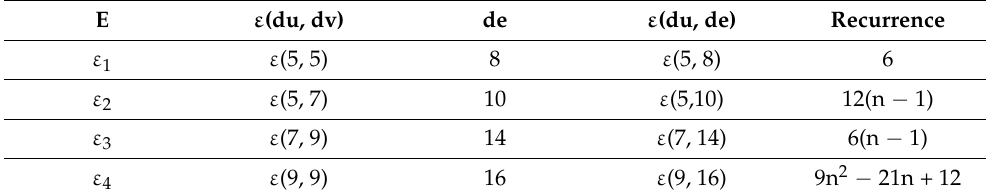
Table 5. Edge partition of honeycomb network.